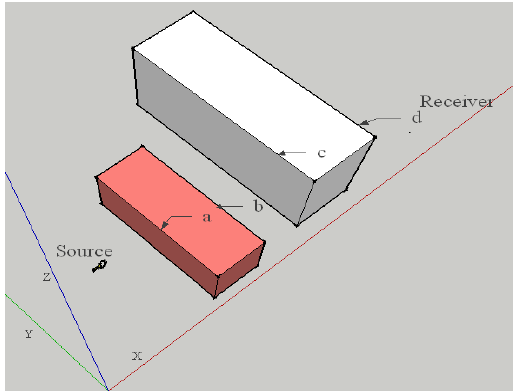
Figure 3. Potential diffracting points over top ( a, b, c, d are potential diffracting points determined by intersection of cutting plane and building roof edges)